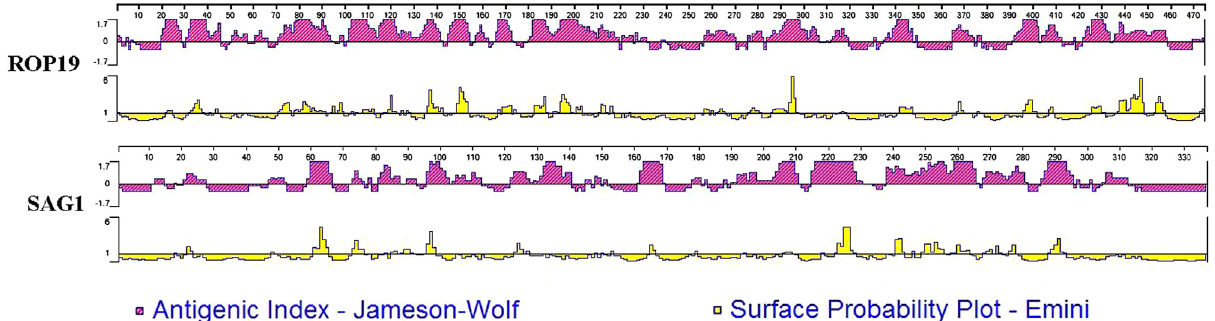
Figure 1. The linear-B-cell epitopes of ROP19 predicted by DNASTAR software in antigenic index and surface probability rules. The antigenic indexes are in red color; The surface probability plots are in yellow